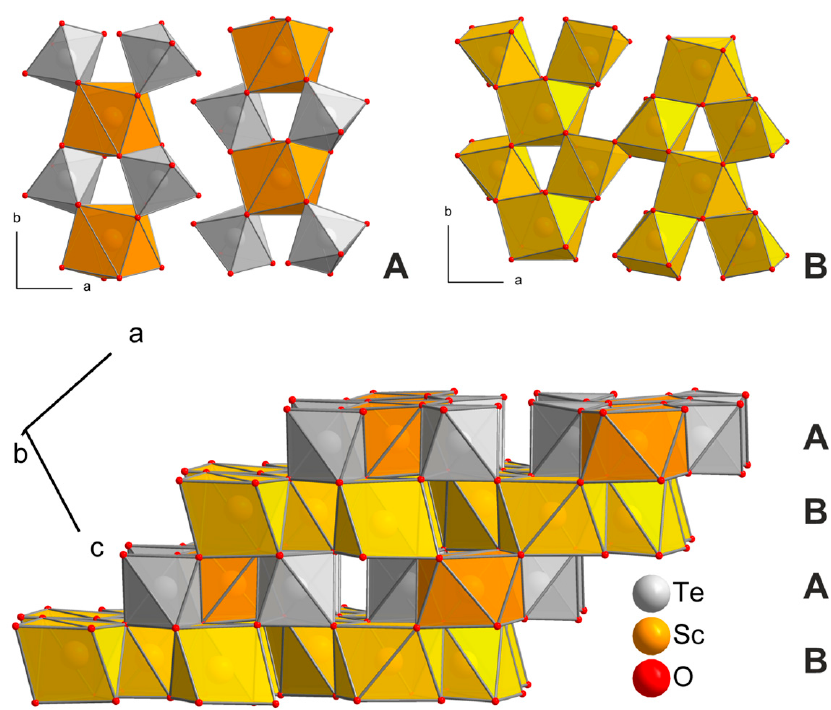
Figure 4. The crystal structure of HP-Sc 2 TeO 6 is shown with view along the b axis (bottom). Layer ( A ) (top left) and layer ( B ) (top right) are displayed along the crystallographic c axis. NP-Sc 2 TeO 6 [11] crystallizes in the Na 2 SiF 6 -type structure (trigonal, P 321, no. 150).